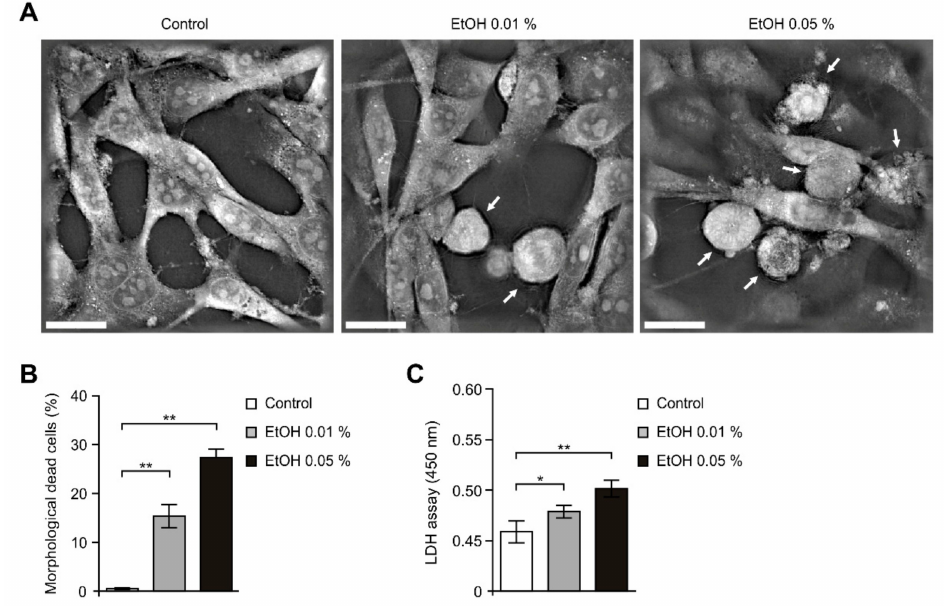
Figure 1. Alcohol exposure induced cytotoxicity in HEI-OC1 cells. ( A ) Representative 3D images of cell death in HEI-OC1 cells treated with ethanol (EtOH, 0.01% or 0.05%) or vehicle (Control) for 4 h. White arrows indicate cells which have the morphological features of cell death. Scale bars, 20 µ m. ( B ) Quantification of the morphological dead cells in HEI-OC1 cells treated with ethanol (EtOH, 0.01% or 0.05%) or vehicle (Control) for 4 h (The percent of morphological dead cells in total 100 cells in 10 individual images per group). ( C ) Cytotoxicity assay of HEI-OC1 cells treated with ethanol (EtOH, 0.01% 0.05%) or vehicle (Control) for 4 h using lactate dehydrogenase (LDH) levels in the culture medium. Data are representative of three independent experiments, and each was done in triplicate. Data are mean ± SEM. * p < 0.05, ** p < 0.01 using the two-tailed Student’s t